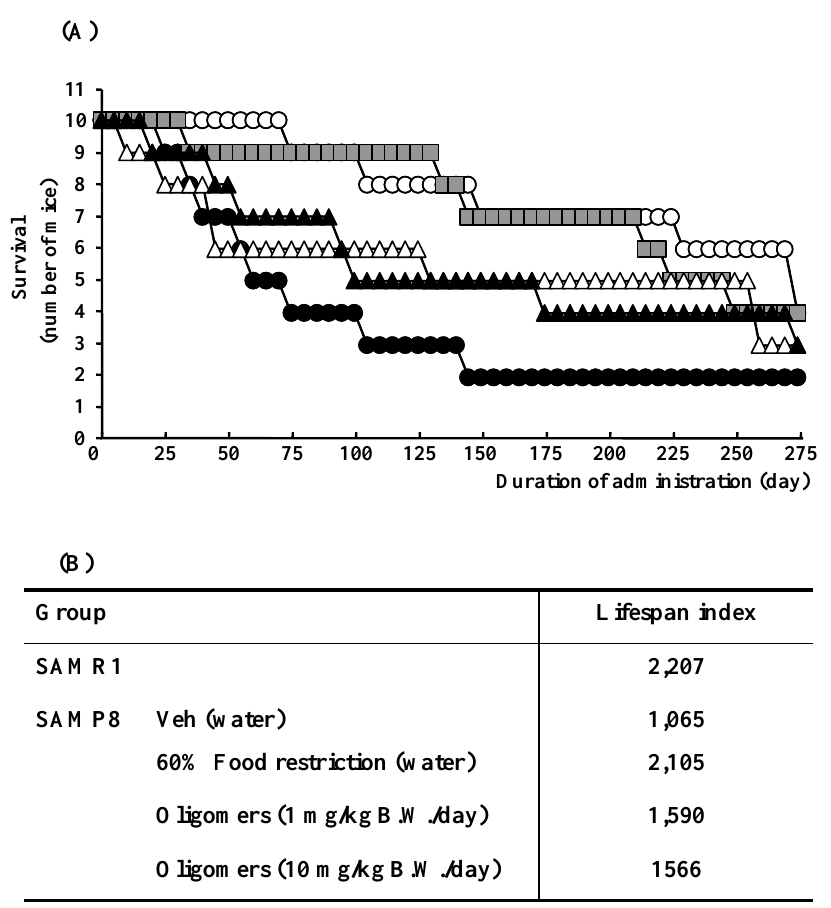
Figure 2. Effects of oligomers on lifespan of SAM. Forty-five or forty-six-week-old SAMP8 mice were administered vehicle (Veh, water p.o., n = 10), while another two groups were administered oligomers orally at doses of 1 or 10 mg/kg body weight/day ( n = 10) using a stomach tube until death. For the remaining group of mice, the mean food intake was restricted to 60% until death ( n = 10). SAMR1 mice (45–46 weeks old, n = 10) were used as a control group. ( A ) Effects of oligomers on survival of SAMP8. ( B ) Lifespan index based on survival data. Open circle: SAMR1; closed circle: SAMP8 (Veh); open triangle: SAMP8 (oligomers at 1 mg/kg B.W./day); closed triangle: SAMP8 (oligomers at 10 mg/kg B.W./day); gray square: SAMP8 (60% food restriction).